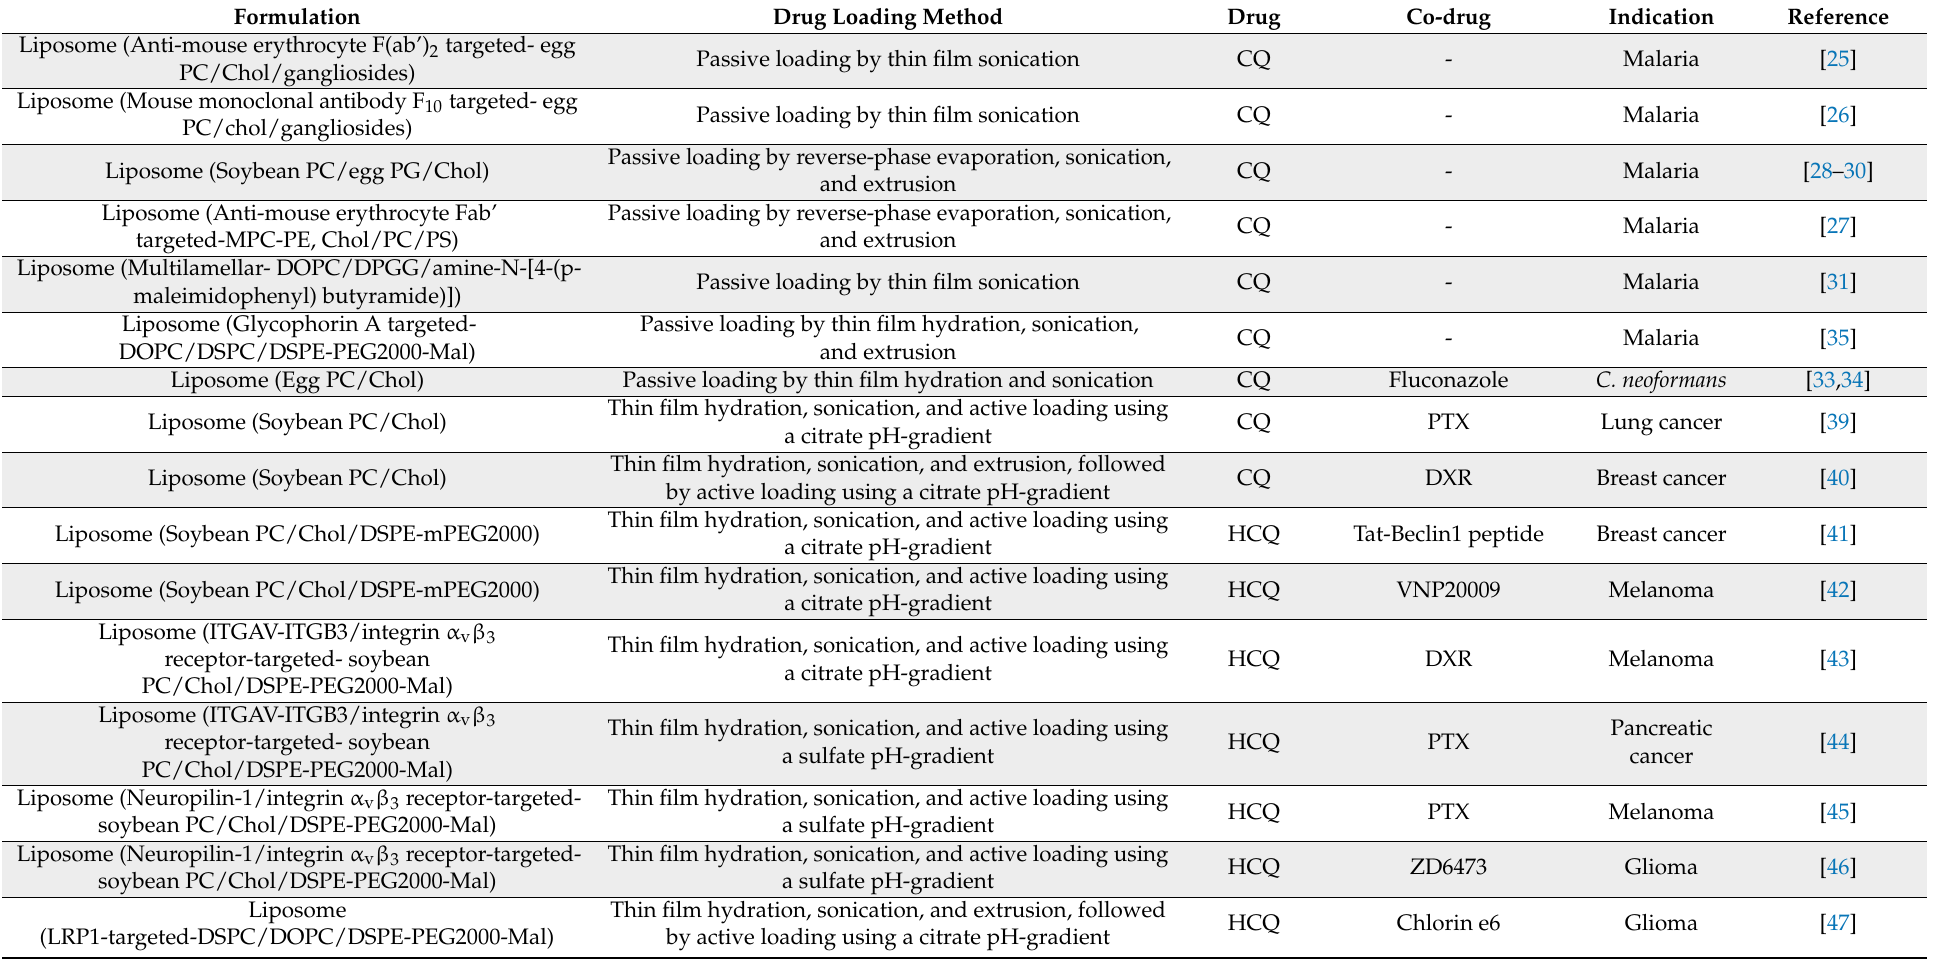
Table 1. Nanomedicine formulations of CQ and HCQ tested in